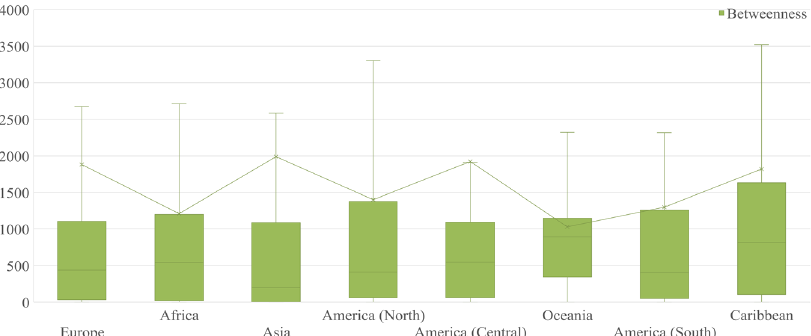
Figure 5. Box plot for betweenness of ports in different continents. Values within the box lie between the inter-quartile range of 0.25 to 0.75. The bar within the box represents the median value and the bar outside the box represents the extreme outlier range. Table 4. Top 30 ports with the highest betweenness